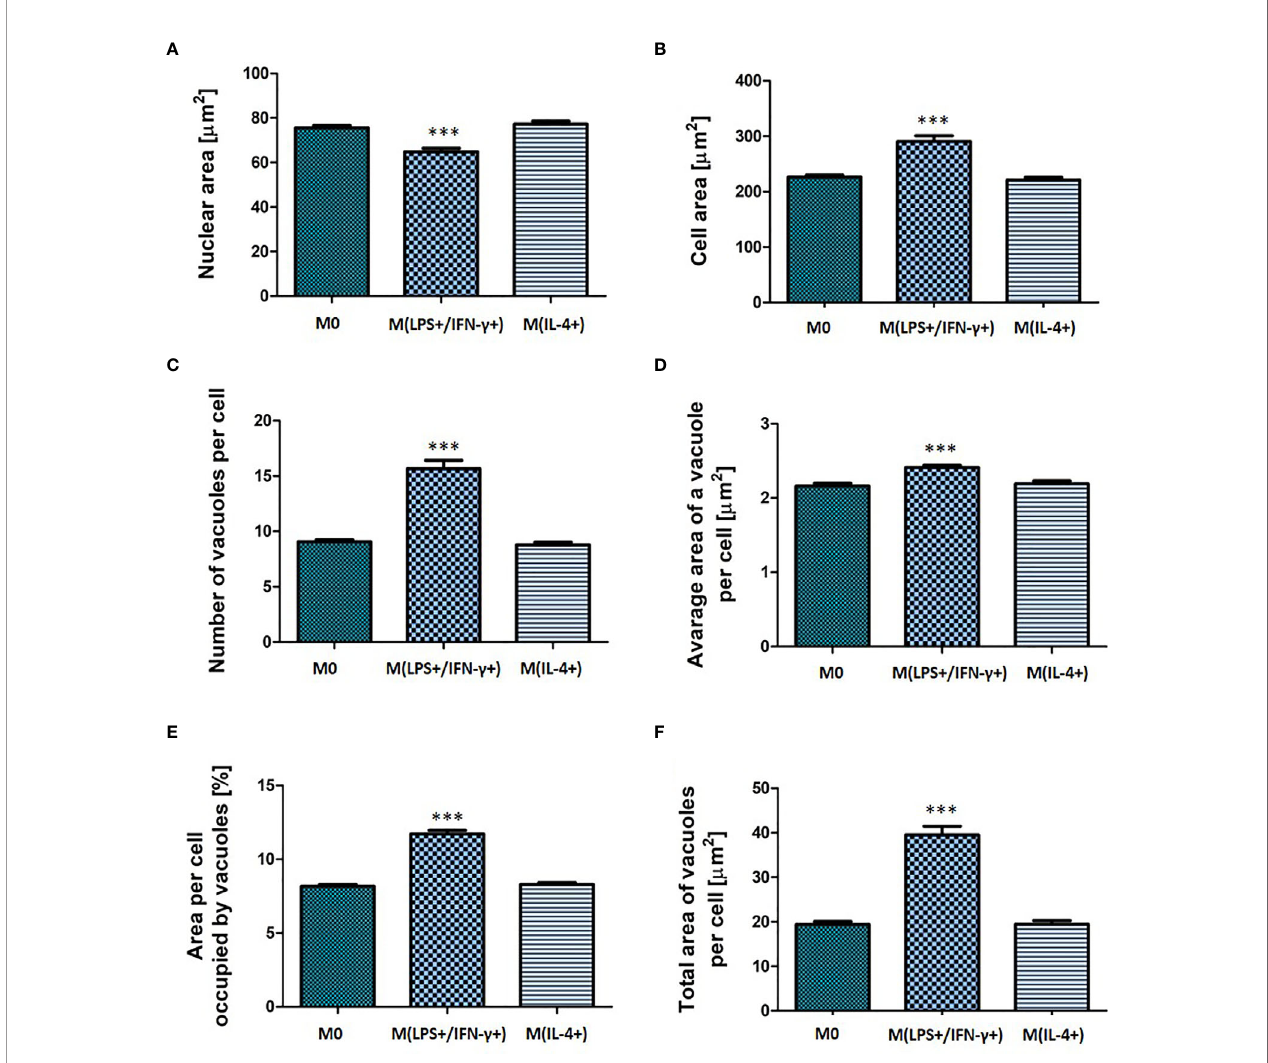
FIGURE 2 | Morphological characteristic of non-activated, M(LPS+/IFN- g +) or M(IL-4+) activated NR8383 rat macrophages. Nuclear area (A) , cellular area (B) , number vacuoles per cell (C) , average area of a single vacuole (D) , cellular area occupied by all vacuoles (E) and total area of all vacuoles per cell (F) were quanti fi ed in non-activated macrophages (M0), activated with 100 ng/mL LPS and 20 ng/mL IFN- g [M(LPS+/IFN- g +)] or activated with 30 ng/mL IL-4 [M(IL-4+)]. Data are presented as mean values ± SEM of three separate experiments. Statistical comparisons are made using a one-way ANOVA analysis with Bonferroni ’ s multiple comparison post-hoc test. Results are compared to non-polarized control (M0); *** indicates p <